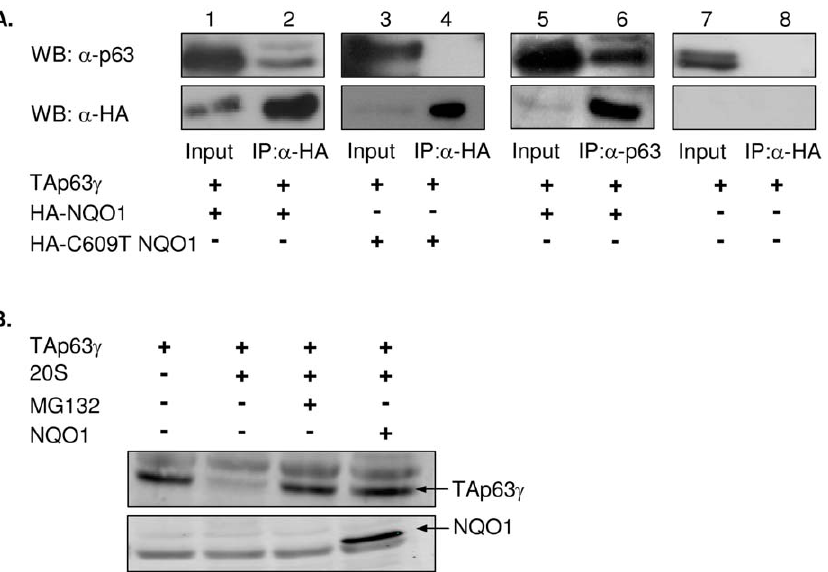
Figure 3. NQO1 physically associates with TAp63 c and protects it from 20S proteasomal degradation. (A) 293 cells stably expressing HA-NQO1 or HA-C609T NQO1 were transfected with a plasmid expressing TAp63 c . Cellular extracts were prepared and subject to immunoprecipitated (IP) with anti-HA or anti-p63 antibodies. Immunoprecipitated proteins and 5% of input material were detected by Western blot using anti-p63 and anti-HA antibodies. (B) Degradation of in-vitro translated, biotin-labeled TAp63 c with 20S proteasome was carried out in the presence or absence of in-vitro translated, biotin-labeled NQO1 and 1mM NADH at 37 u C for 4h. Biotin-labeled TAp63 c and NQO1 were detected with fluorescently-labeled streptavidin.